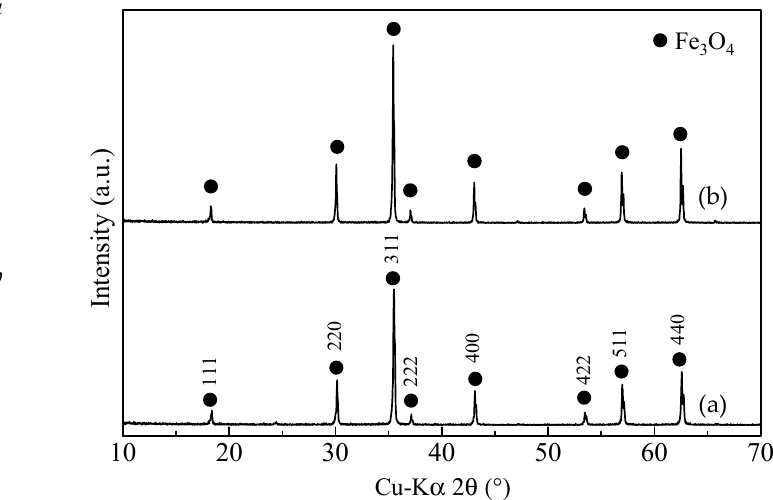
Figure 2. X-ray diffraction patterns of ( a ) the powder prepared by the reduction of α -FeOOH in the mixed solvent with 9 vol. % water concentration at 200 °C for 24 h; ( b ) the powder prepared by reduction of α -FeOOH with 12 vol. % water concentration at 200 °C for 48 h.